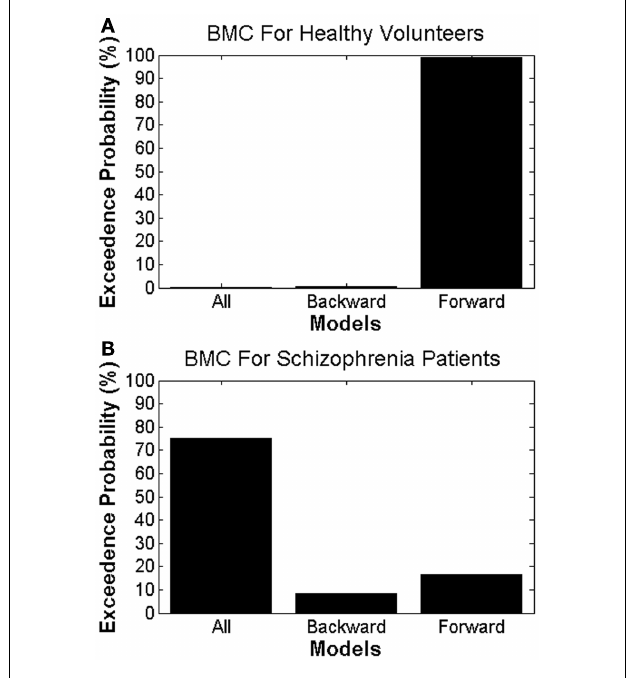
FIGURE 4 | Bayesian model comparison results for (A) healthy volunteers and (B) patients with schizophrenia, showing the exceedance probabilities for each DCM model